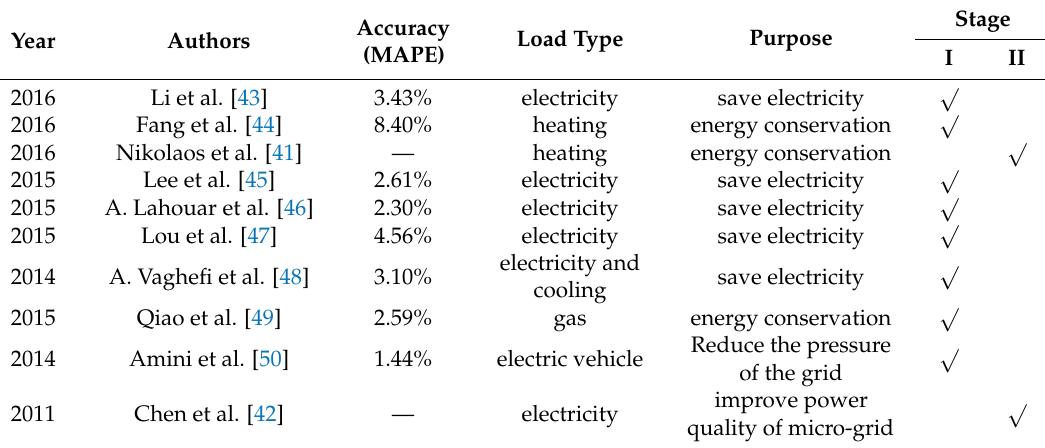
Table 3. Current situation of research and application of load forecasting.